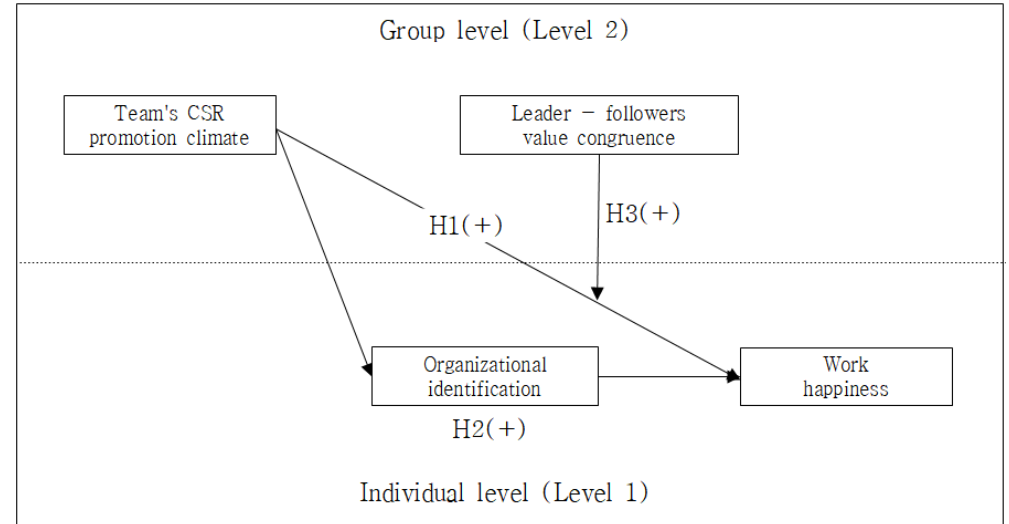
Figure 1. Study Model.